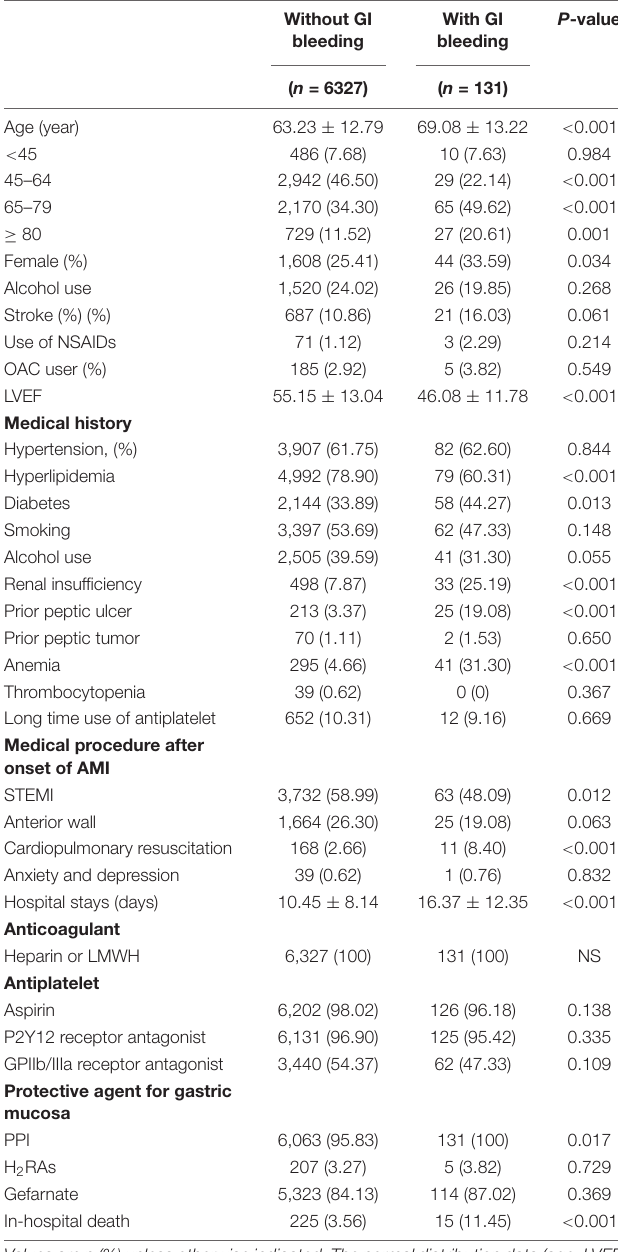
TABLE 1 | Baseline characteristics of the study patients according to gastrointestinal bleeding (GIB) event.